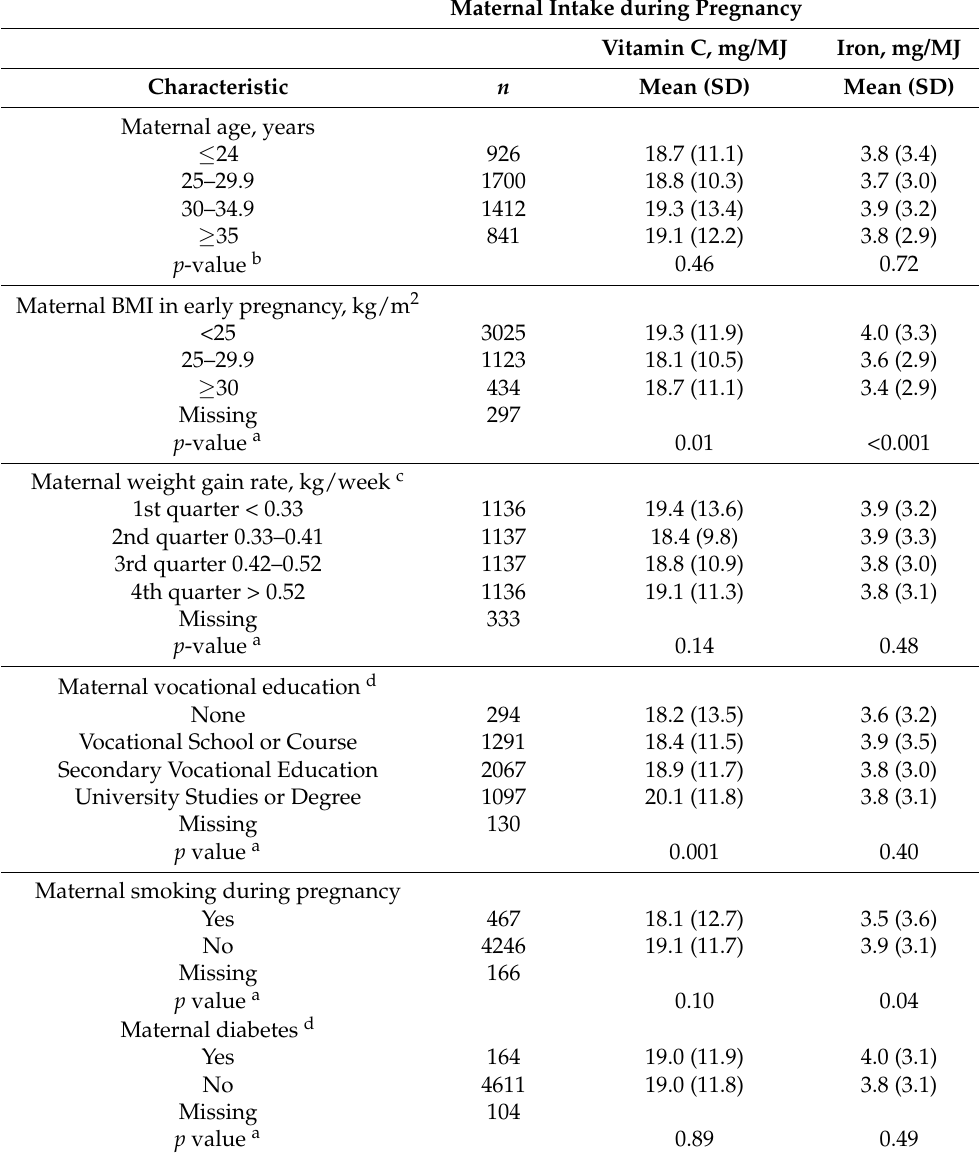
Table 1. Characteristics of 4879 mothers in relation to mean (standard deviation) total intake of vitamin C during and iron 8th month of